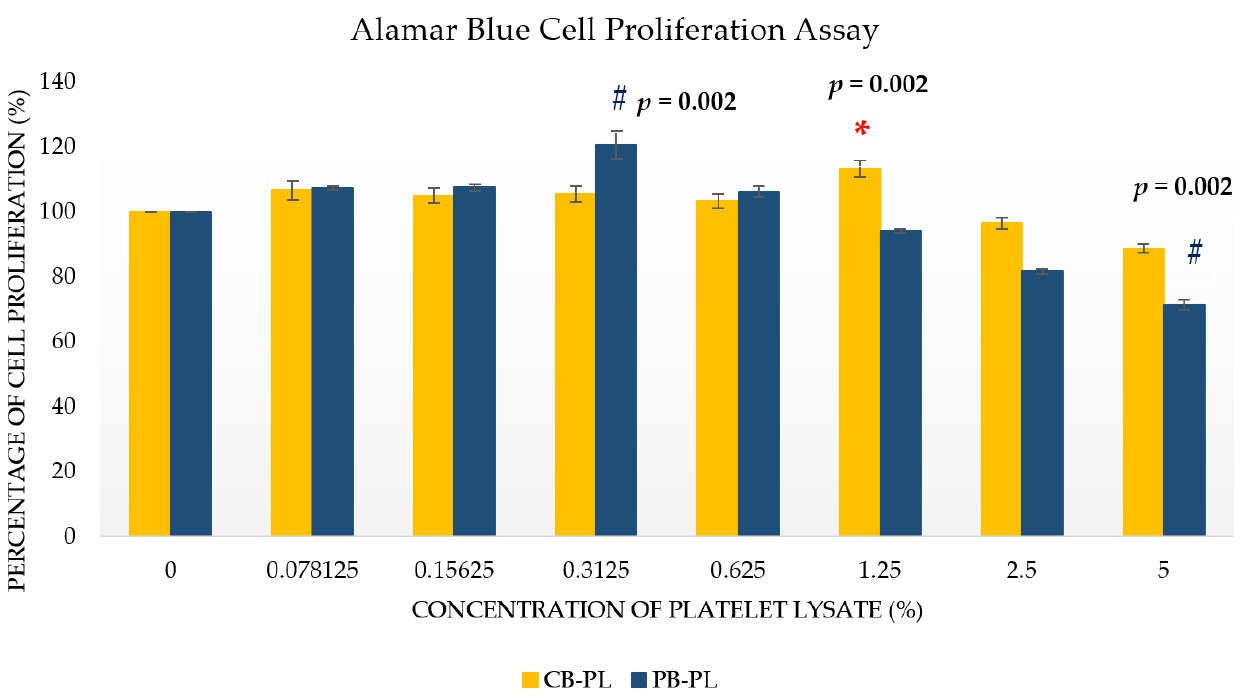
Figure 1. The percentage of cell proliferation for CB-PL and PB-PL were calculated vs. the serum-free medium/CTRL (normalized as 100%). All data were representative of six independent tests with n = 6 by groups and means ± SEM. * p < 0.05 denoted the statistical signi fi cance of CB-PL concentra- tions when CTRL (0% PL). # p < 0.05 denoted the statistical signi fi cance of PB-PL concentrations when compared to CTRL (0%).